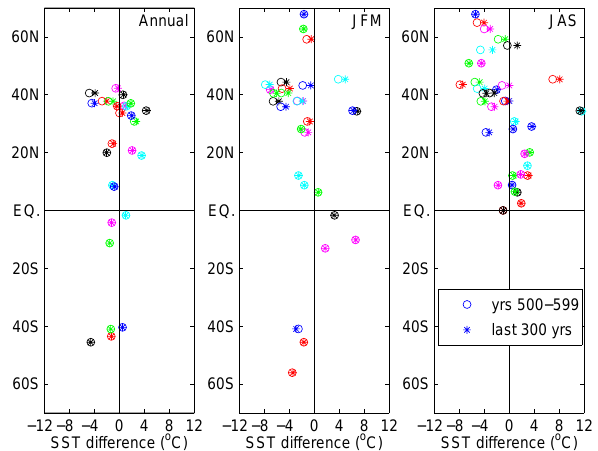
Fig. 4. The difference between simulated and proxy SST ( δ ) for annual mean (left panel), January–March (middle panel), and July– September (right panel). The difference is displayed based on model years 500–599 (circles) and for the last 300 yr of the GS12 simulation (asterisks). For clarity, the same colour is used for the two differences corresponding to the same proxy